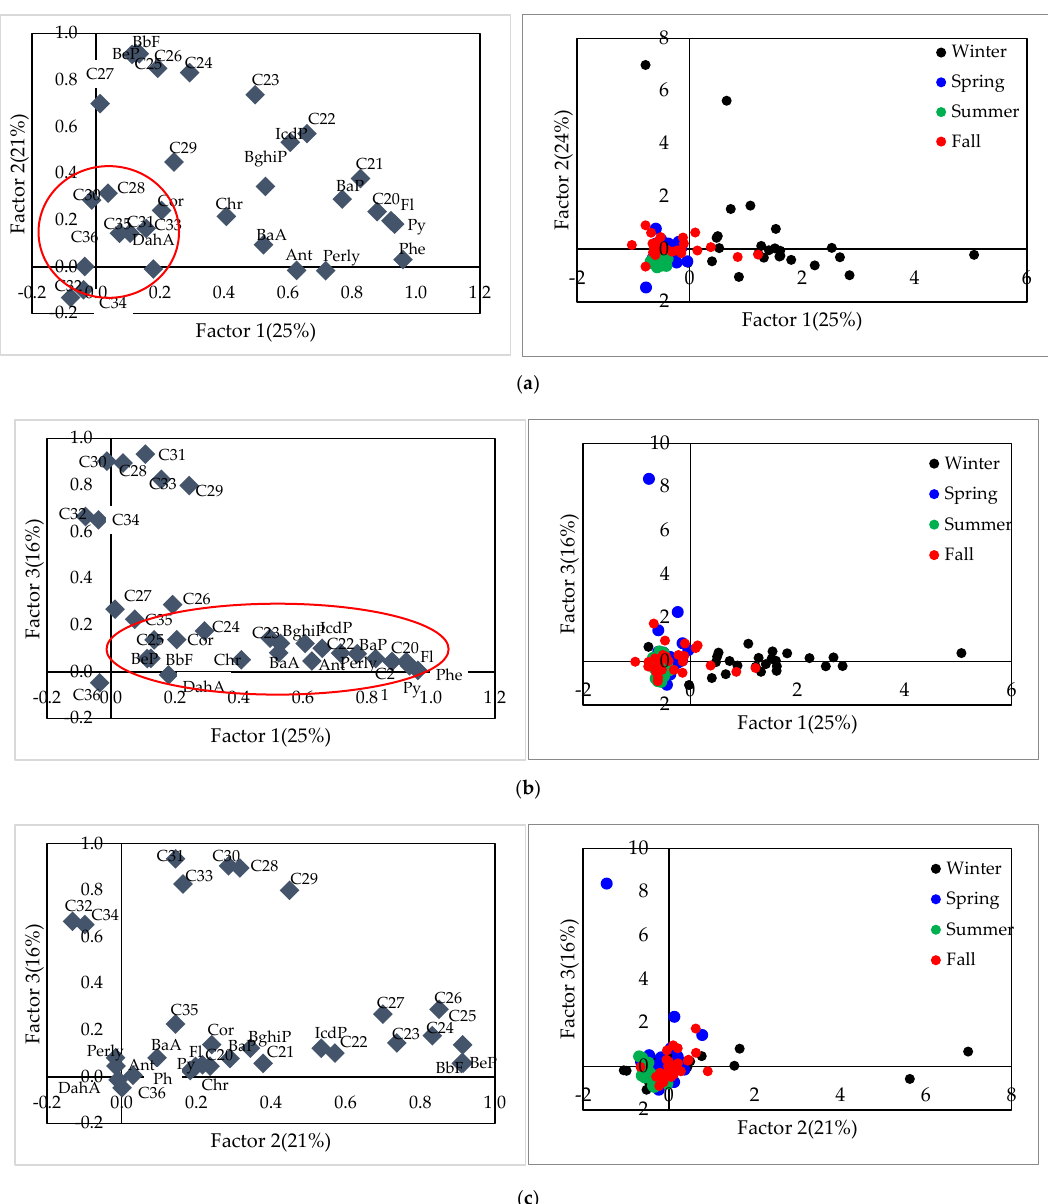
Figure 7. Loading plots and Score plots of ( a ) Factor 1 and Factor 2; ( b ) Factor 1 and Factor 3; ( c ) Factor 2 and Factor